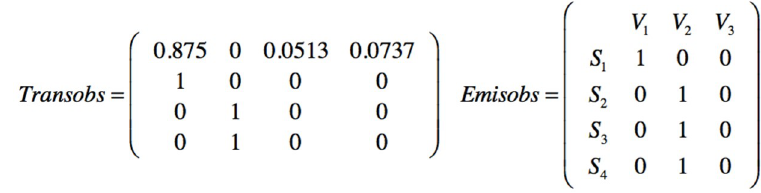
Figure 32. Posterior transition and emission matrices.